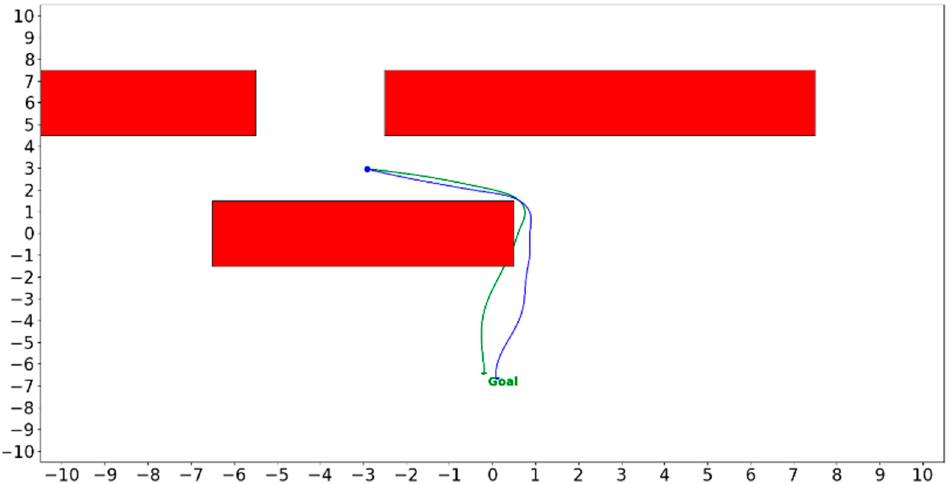
Figure 16. Collision with obstacles ( green ), collision avoidance by sampling more experiences close to obstacles ( blue ).